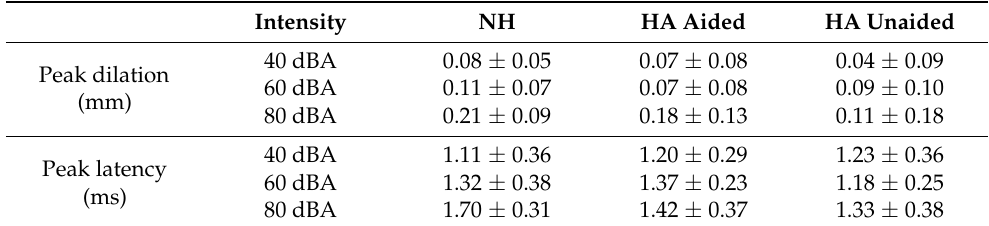
Figure 5. Boxplots of peak pupil diameter ( top ) and latency ( bottom ) in response to 1-kHz tone bursts at 40, 60, or 80 dBA for the NH for the NH group and the HA group with the HA on or off. The boxes show the 25th and 75th percentiles, the error bars show the 10th and 90th percentiles, the filled circles show outliers, the horizontal lines show the median, and the white stars show the mean. Table 6. Mean ± standard deviation for peak pupil diameter and latency for the NH group and the HA group (aided or unaided) at each intensity.